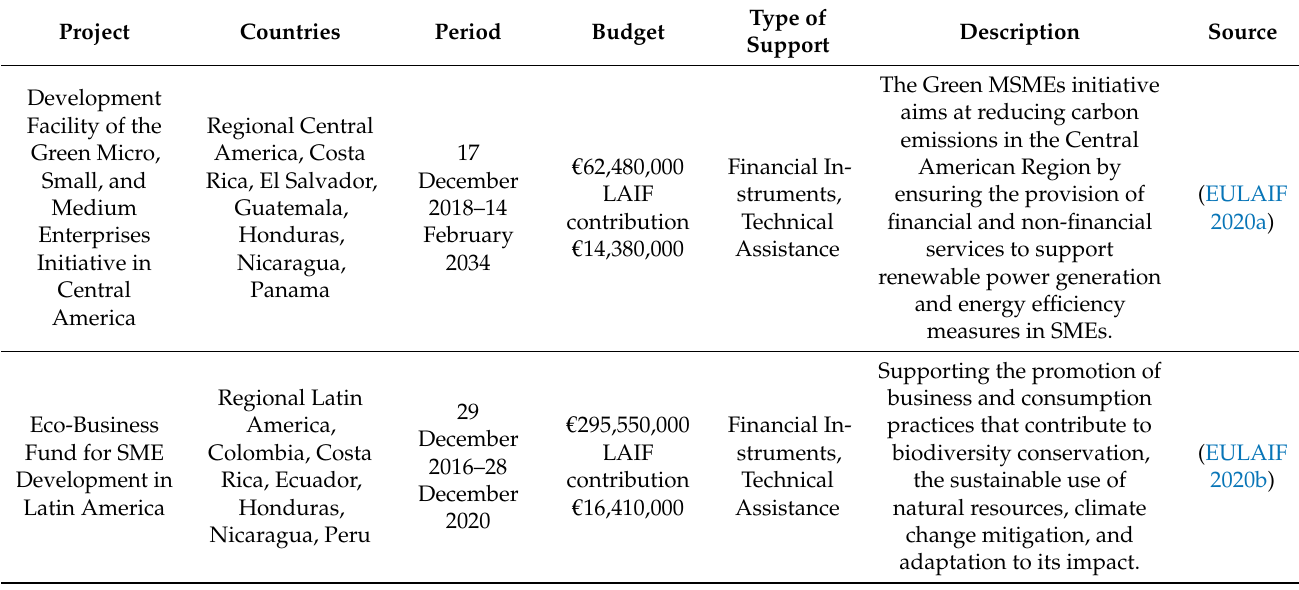
Table 4. Examples of responsible financing projects in Latin America and the Caribbean.